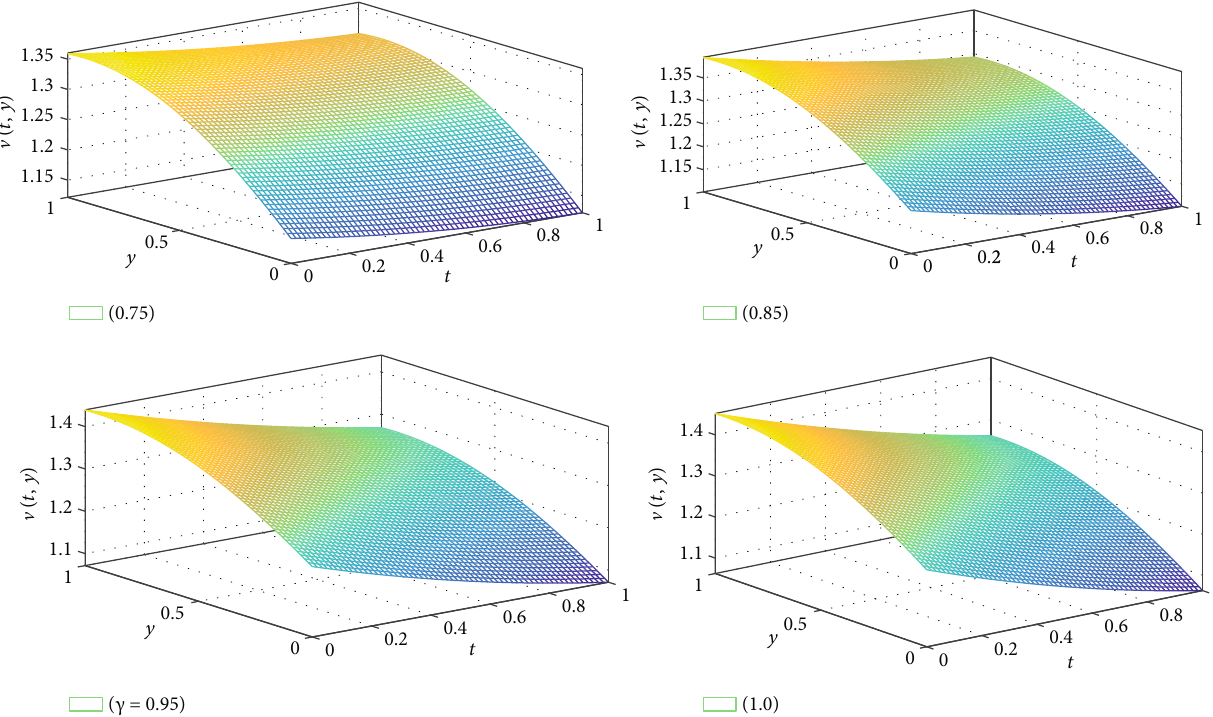
Figure 1: Surface plots of the required solution up to four terms at di ff erent values of γ for Example 1. Table 1: Comparison between the absolute error at VHPM [40] and the present method (LADM) with the exact solution of Example 1. y ⟶